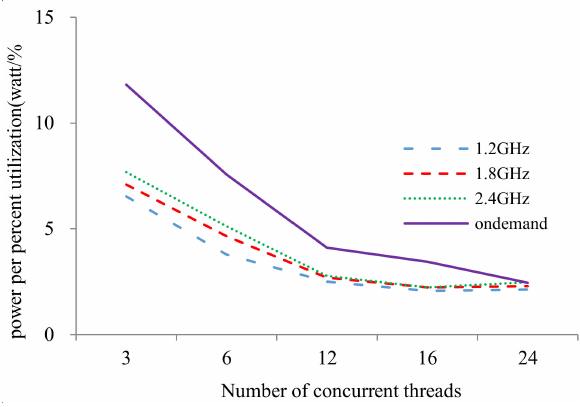
Figure 12. Power per percent memory utilization of server #2 with array size = 8 GB.